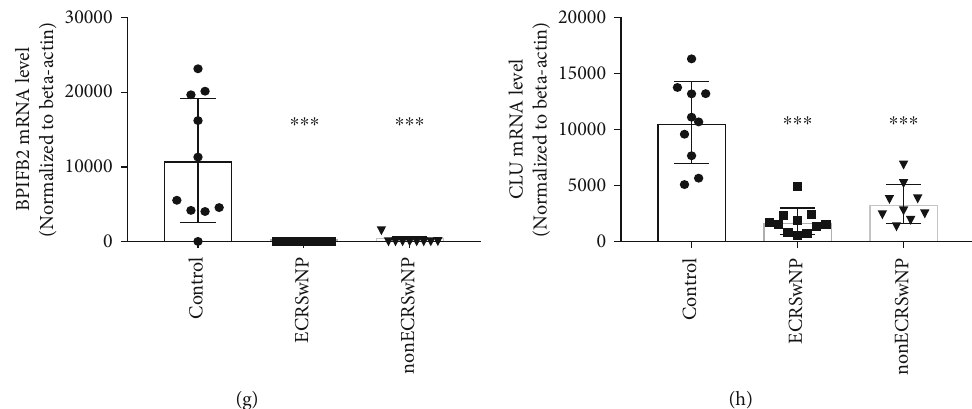
Figure 1: Expression of top abundant AMPs in nasal tissues. (a) Expression of the 10 most abundant AMPs in nasal tissues from ECRSwNP, nonECRSwNP, and healthy controls identi fi ed by RNA sequencing. The color coding of heat maps represents the gene expression level normalized to the control group, which is calculated based on Transcripts Per Million (TPM). A signi fi cant di ff erence in the expression of BPIFA1 was found between the ECRSwNP and nonECRSwNP groups. (b – h) The expression of AMPs (BPIFA1, SLPI, BPIFB1, LYZ, LTF, BPIFB2, and CLU) in nasal tissue of ECRSwNP, nonECRSwNP, and healthy controls veri fi ed by real-time PCR. ∗ P < 0 : 05 , ∗∗ P < 0 : 01 , and ∗∗∗ P < 0 : 001 . AMPs: antimicrobial peptides and proteins; CRSwNP: chronic rhinosinusitis with nasal polyps; ECRSwNP: eosinophilic CRSwNP; BPIFA: BPI fold-containing family A member; BPIFB: BPI fold-containing family B member; CLU: clusterin; LTF: lactoferrin; LYZ: lysozyme; SLPI: secretory leukoprotease